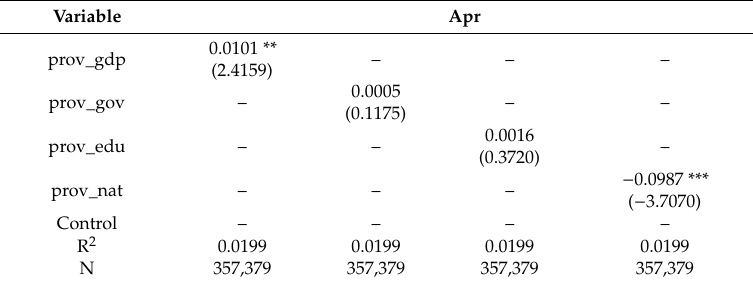
Table 9. Results of the robustness test of the borrowing rate (change sample).